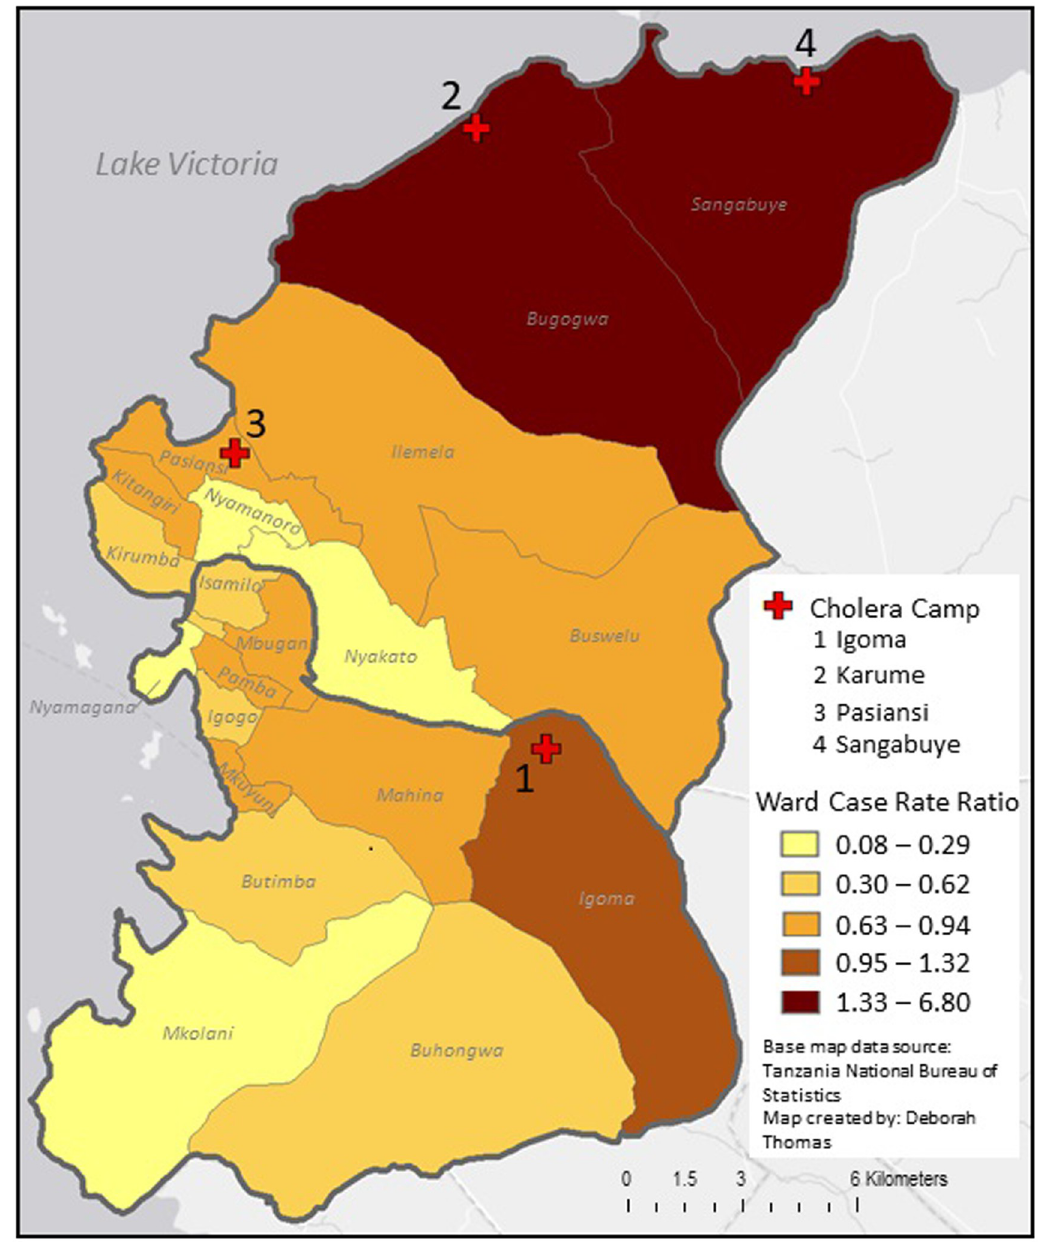
Fig 3. Case ratio of ward as compared to the case ratio of Mwanza City for patients attending cholera camps for treatment during the August 2015- April 2016 outbreak. Base map data source: OCHA, https://data.humdata.org/dataset/cod-ab-tza. Map created by: Deborah